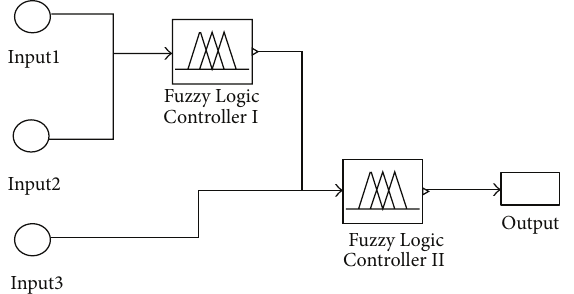
Figure 5: The connection of FLC1 and FLC2.